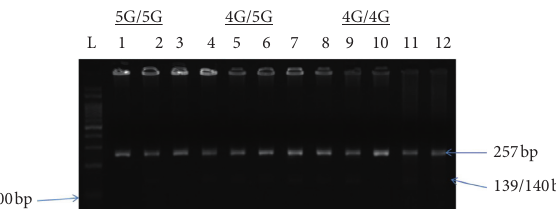
Figure 1: Amplified product of the 4G/5G polymorphism. L 100bp ladder, lanes 1 to 4 for 5G allele, lanes 9 and 10 for 4G allele, and lanes 5, 6, 7, 8, 11, and 12 for 4G/5G heterozygous